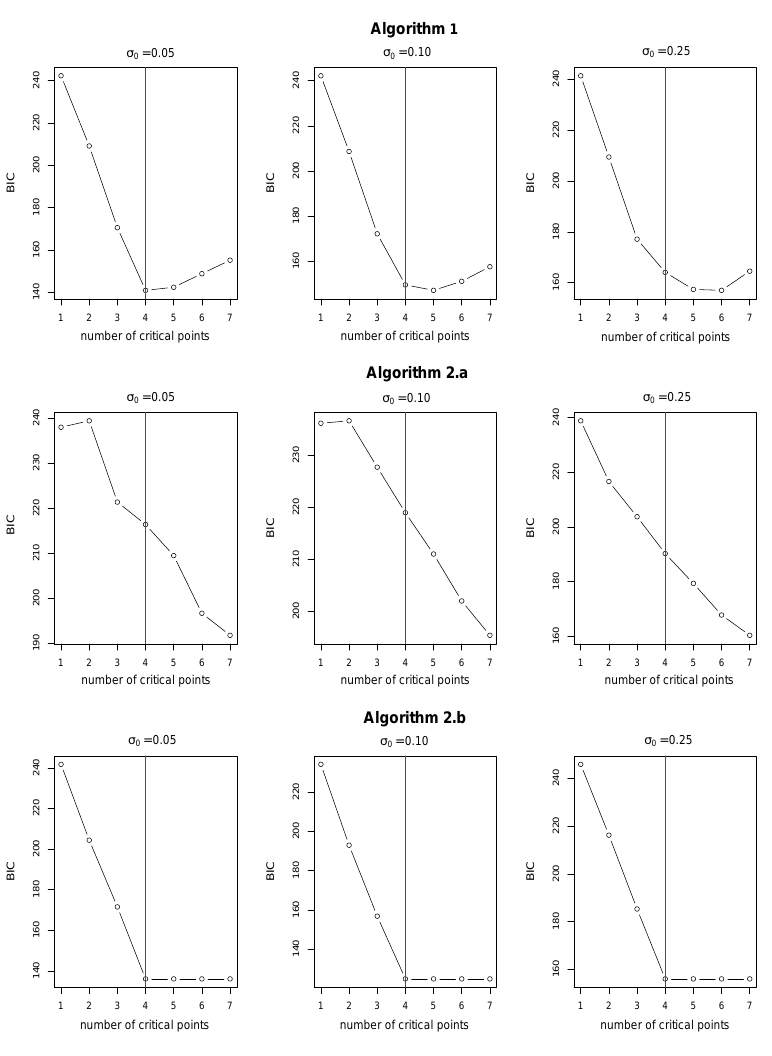
Figure 4. BIC vs. number of critical points ˜ K under the Algorithm 1 ( left ), Algorithm 2.a ( middle ) and Algorithm 2.b ( right ), for σ 0 = 0.05 ( top ), σ 0 = 0.10 ( middle ) and σ 0 = 0.25 ( bottom ).